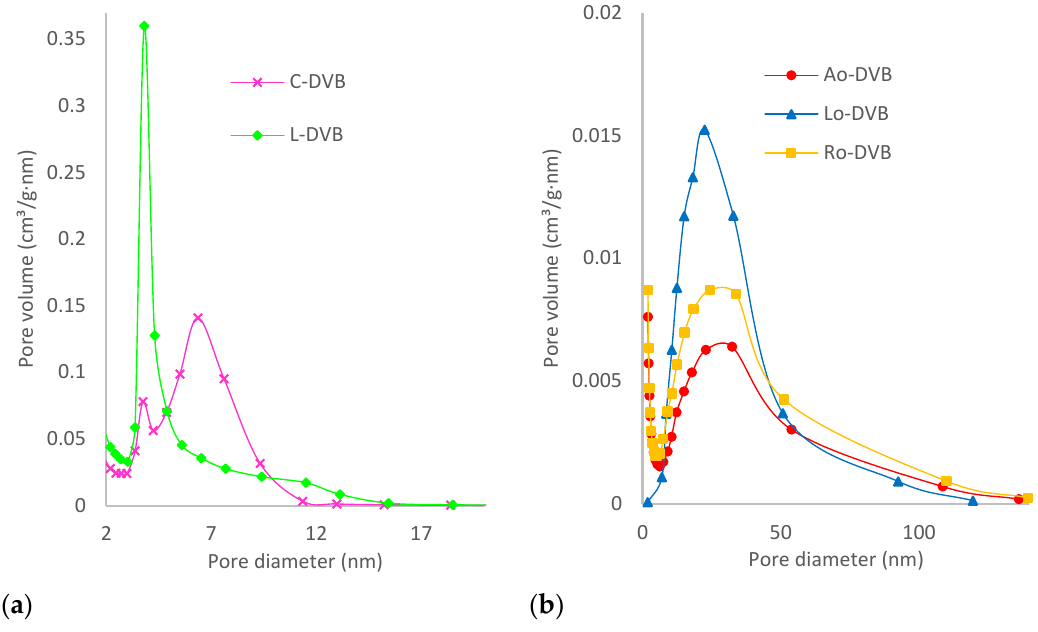
Figure 5. The pore size distribution plots ( a ) C-DVB and L-DVB, and ( b ) Ao-DVB, Lo-DVB, and Ro-DVB.